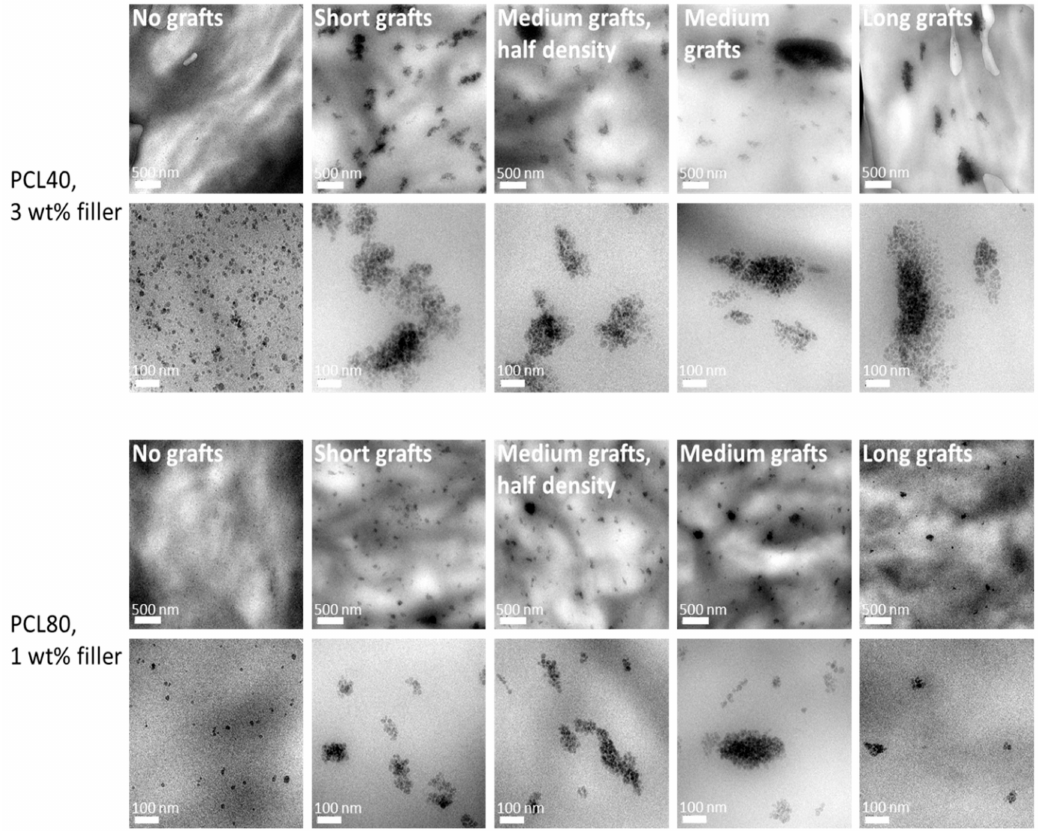
Figure 5. TEM images of PCL / silica composites based on PCL40 matrix and 3 wt% filler (top two rows), and PCL80 matrix and 1 wt% filler (bottom two rows) at two di ff erent magnifications. For each top row the scale bar is 500 nm and for each bottom row it is 100